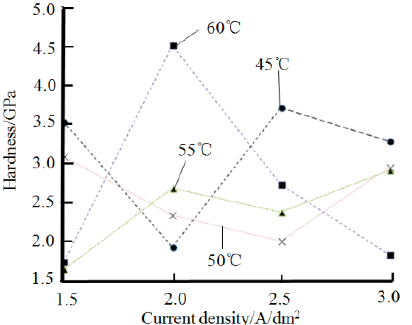
Figure 7. Relationship between current density, plating bath temperature, and hardness of the plated layer.